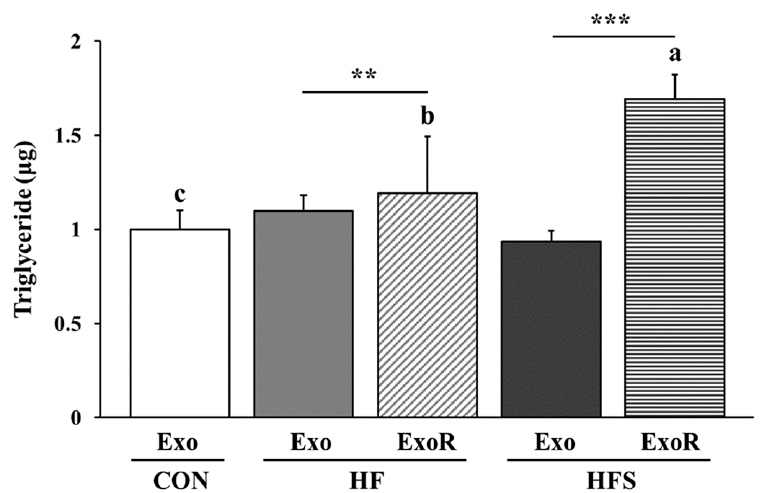
Figure 6. Triglyceride levels in differentiated 3T3-L1 cells treated with liver-derived exosomes from mice. C57BL/6J mice were fed an AIN-93G (CON), high-fat (HF; AIN-93G with 60 kcal% fat), or high-fat diet with 10% sucrose water (HFS) for 12 weeks. Cells were treated with 50 µ g/mL of liver- derived exosomes from the CON (CON-Exo), 50 µ g/mL exosomes from the HF (HF-Exo), 50 µ g/mL exosomes from the HFS (HFS-Exo), 122.5 µ g/mL exosomes from the HF (HF-ExoR), and 121.5 µ g/mL exosomes from the HFS (HFS-ExoR) groups. The levels of HF-ExoR and HFS-ExoR were obtained from the differential ratio to normalize the values to the weight of liver tissue. All data are expressed as the mean ± standard deviation. Different letters (a > b > c) indicate significant differences among CON-Exo, HF-ExoR, and HFS-ExoR. Multiple comparisons of means were performed using Duncan’s multiple range test at the 0.05 significance level. Statistical analyses were performed using Student’s t -test ( n = 3, Exo vs. ExoR; **, p < 0.01, ***, p < 0.001).